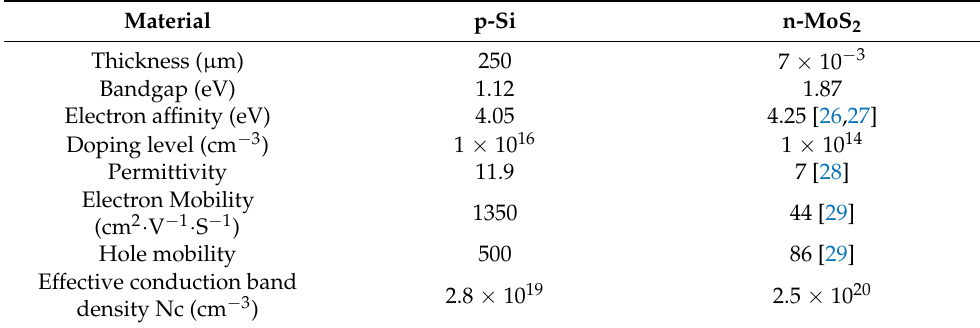
Table 2. Simulation parameters of n-MoS 2 /p-Si heterojunction solar